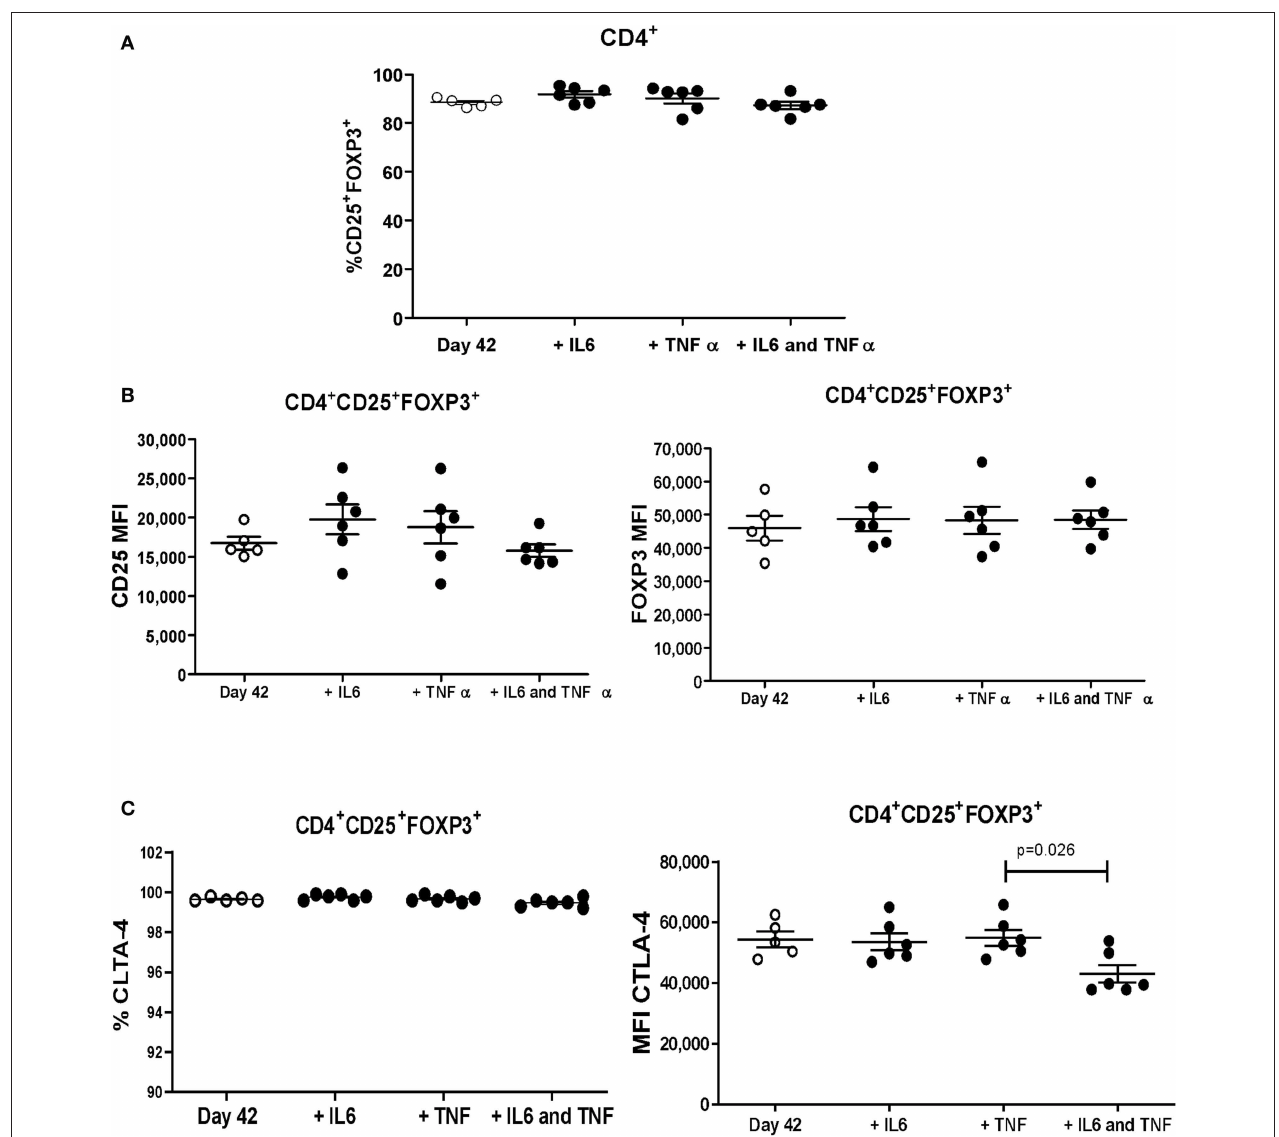
FIGURE 5 | Allospecific iTregs expanded in the presence of pro-inflammatory cytokines maintain the frequency and levels of expression of CD25 and FOXP3. Allospecific CD4 + CD25 ++ CTV − cells ( Figure 2 ) expanded for 4 weeks were polyclonally stimulated for two additional weeks with IL-6 and TNF α . (A,B) No differences in frequency of CD25 + FOXP3 + were observed when the iTregs were expanded in the presence of IL-6 and/or TNF- α (A) ; similar results were observed in the expression of CD25 and FOXP3 (B) . (C) Percentage of CTLA-4 + cells within the CD25 + FOXP3 + population is maintained in the presence of cytokines, although the expression levels were significantly diminished. MFI values were calculated as above. Data represent the mean ± SEM from n = 5–6 donors from three independent experiments. The statistical analysis was performed using the non-parametric Mann–Whitney test, two-tailed. P < 0.05 was considered statistically